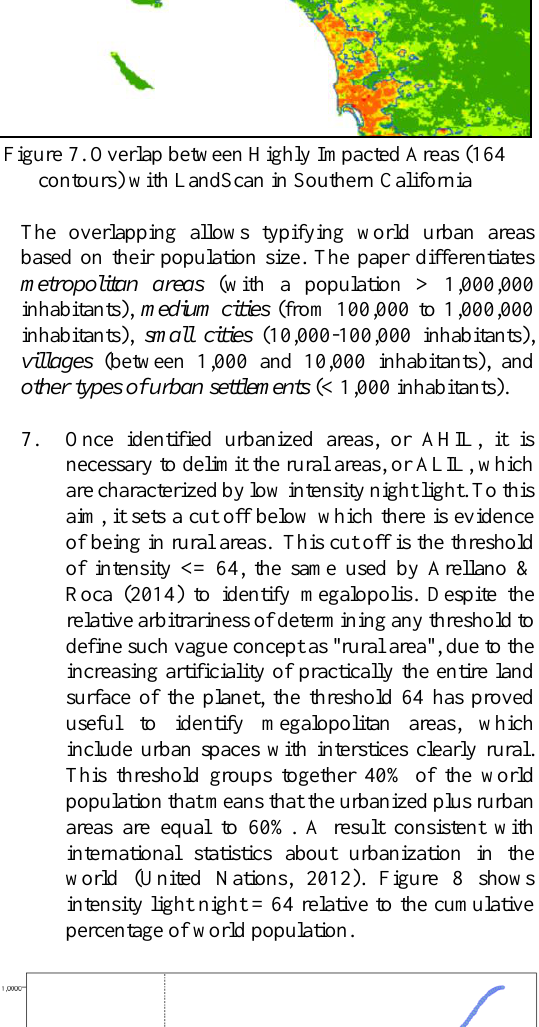
4 The selected agglomerations are sorted by population of the illuminated contours with intensity of 164 (AHIL). If sorting was been made by the light intensity contour of 64 (which